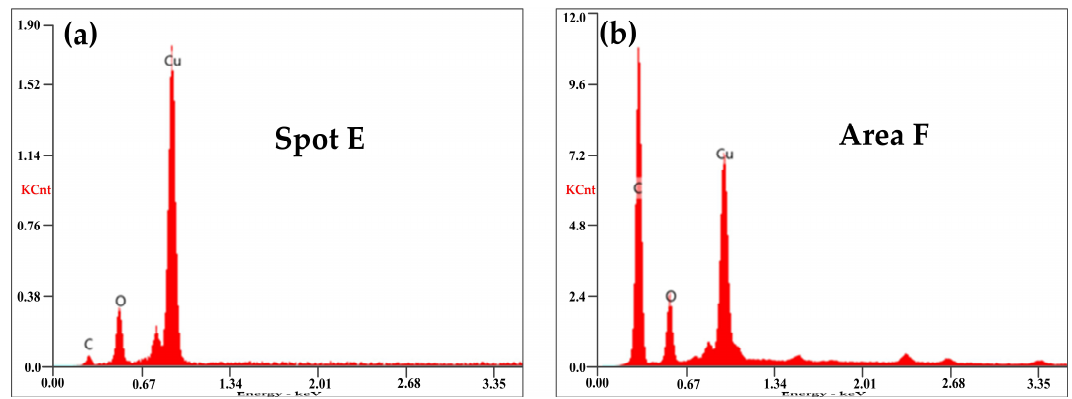
Figure 14. EDX of the selected area: ( a ) ablation products from Figure 13c; ( b ) debris from Figure 13d.